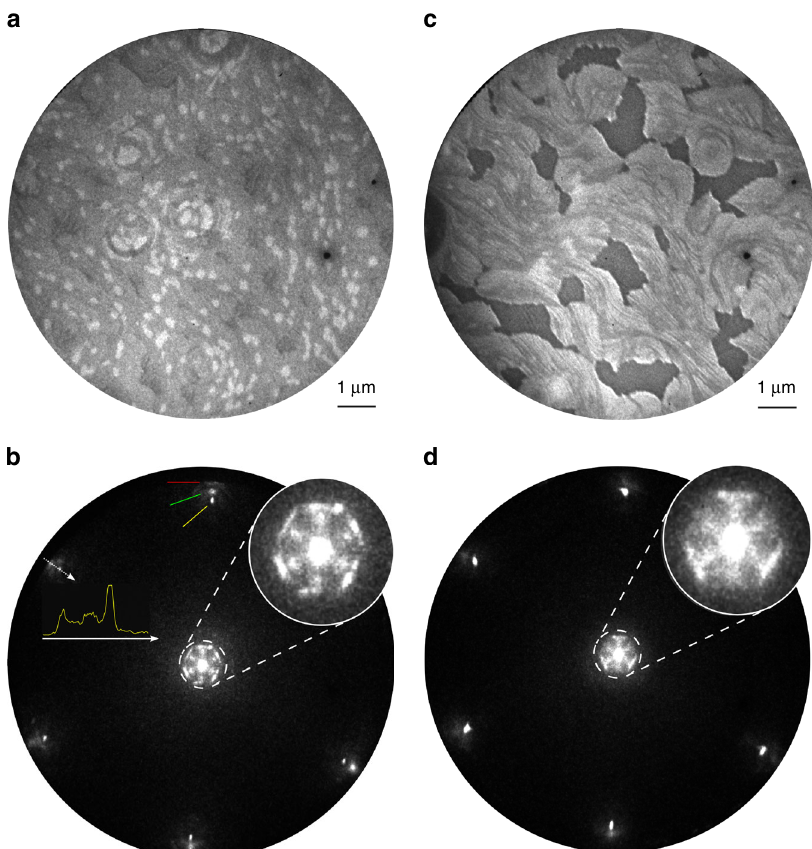
Fig. 4 In situ LEEM investigation. a LEEM image and b µ -LEED pattern of a BCN layer grown by using as precursor gas a mixture of borazine and ethylene. The small white islands are graphene seeds grown during the fi rst 120 s of growth, when only ethylene was in the chamber. The line pro fi le shown in yellow has been taken from the white arrow across the (11) diffraction spots of the BCN layer. Following the direction of the arrow , the fi rst diffraction spot is due to graphene lattice, the second one to the true BCN domains and the last one to Ir substrate. LEEM image ( c ) and µ -LEED pattern ( d ) of a BCN layer grown by using as a precursor gas a mixture of borazine and ethylene that were pre-mixed prior to being inserted into the growth chamber. The LEEM images were taken with a start voltage of 18.4 V ( a ) and 18.0 V ( c ). The µ -LEED patterns were collected with a start voltage of ( b ) 34 V and ( d ) 47 Fig. 5 to represent a mixture of graphene regions and alloyed